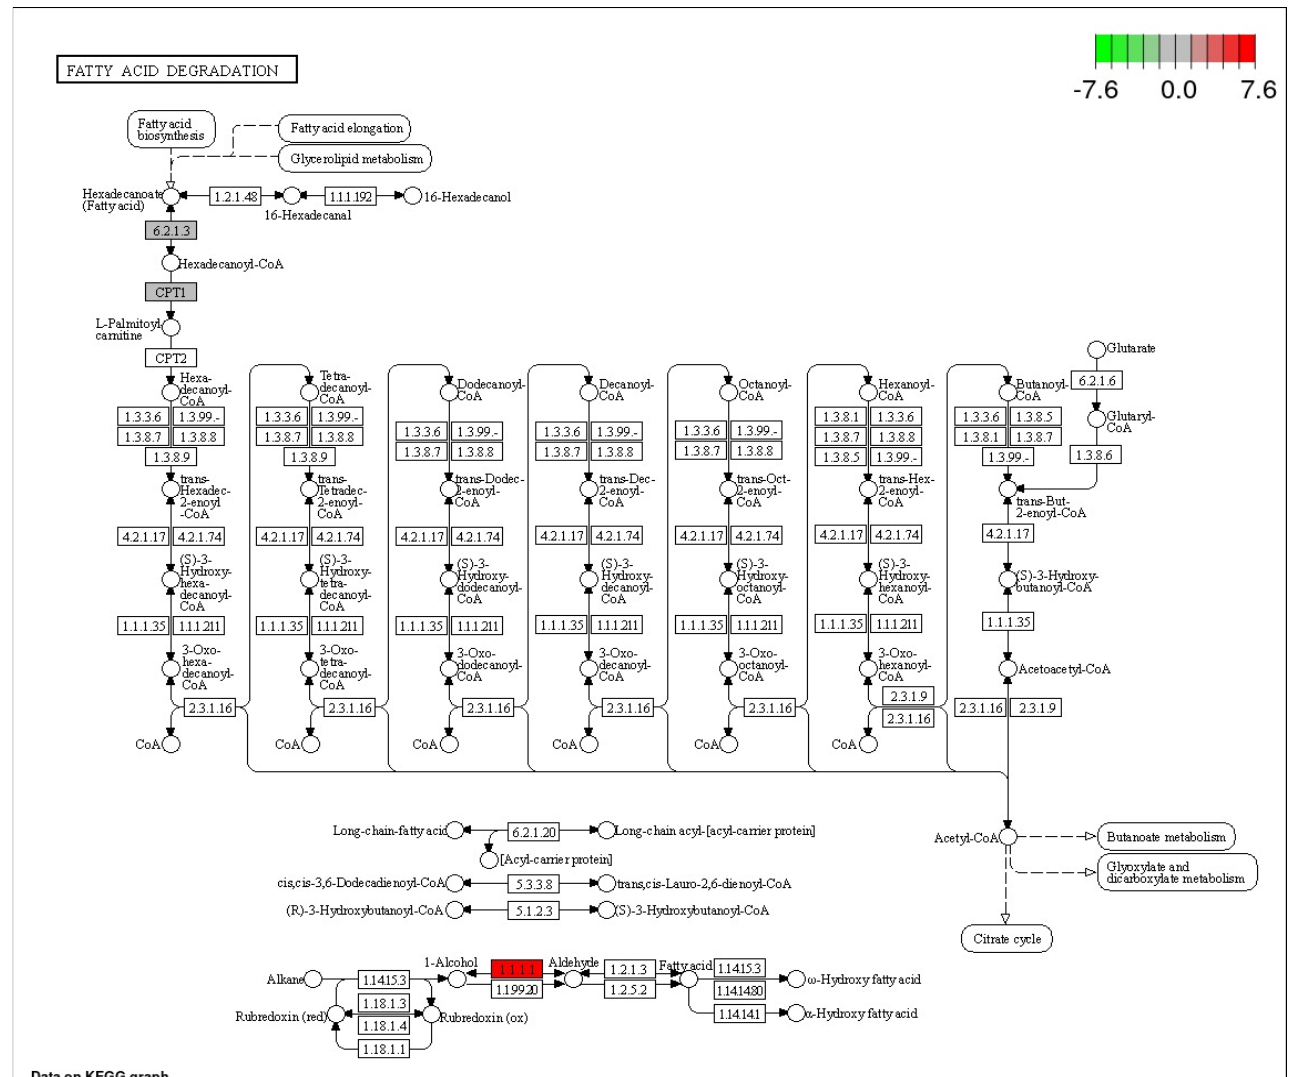
Figure 9. Adrenergic signaling pathway showing the pathway terms that are enriched in ammonia treatment. The color shades refer to the extent of up-regulation.